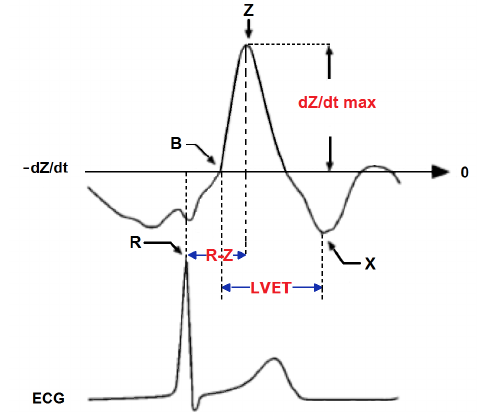
Fig. 3 Analysed ICG and ECG waveforms. The singular point dZ/dtmax (Z-spot), LVET (time from B to X-spot) and R-Z (time from R to Z-spot) parameters are